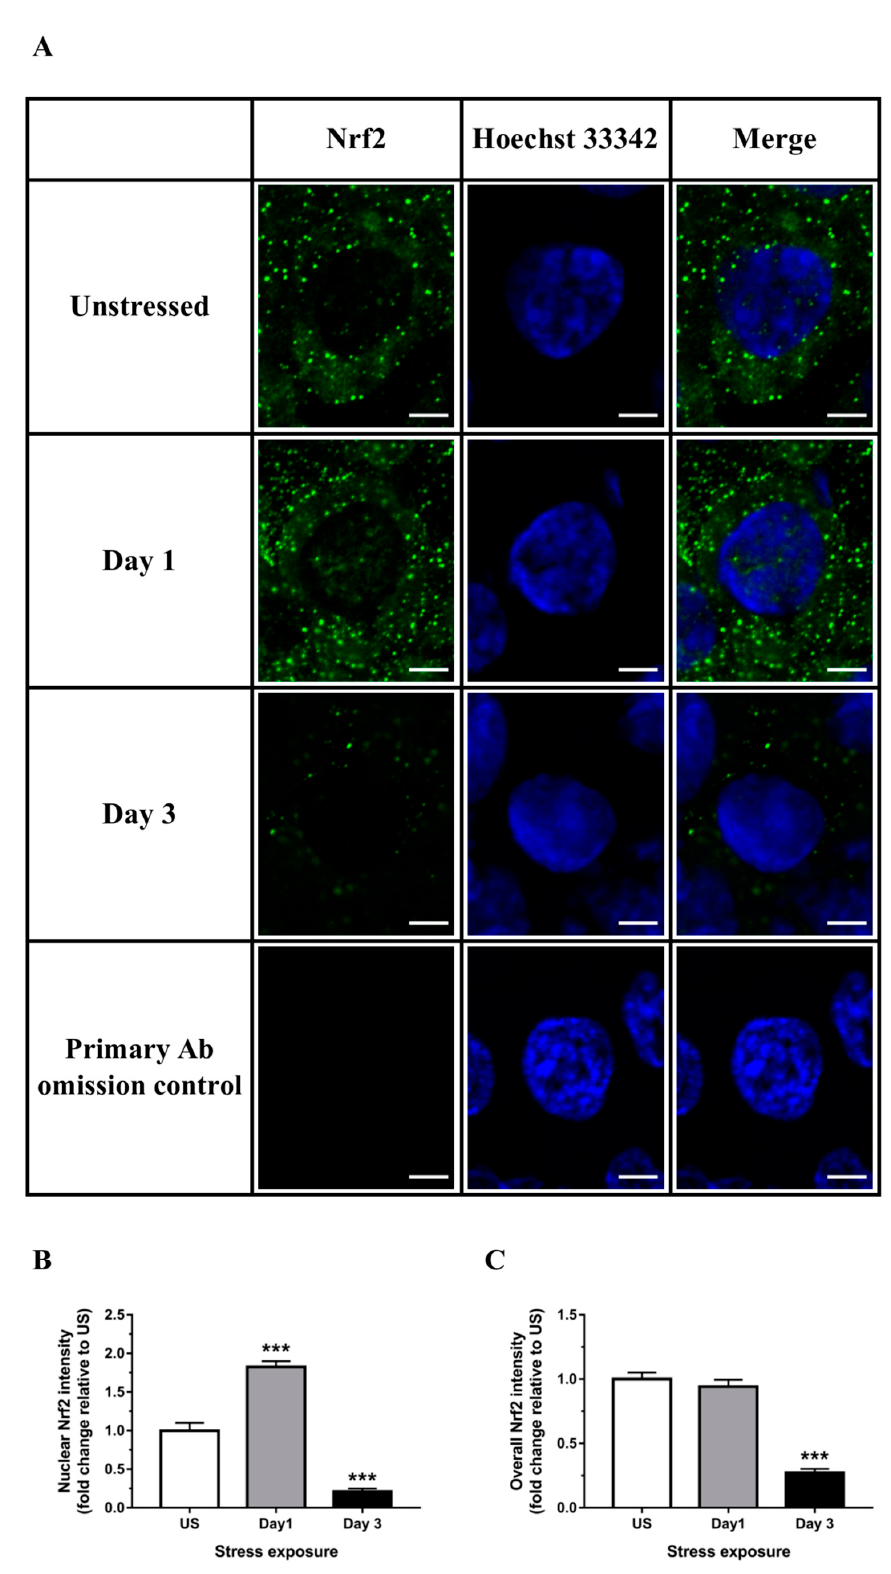
Figure 7. Representative ( A ) immunofluorescence images (scale bar = 5 µm) and image quantification of ( B ) corresponding nuclear Nrf2, and ( C ) overall Nrf2 from tissue sections in the liver (n = 3). Results in ( B ) were analyzed using one-way ANOVA with Fisher’s LSD test. Data are expressed as mean ± SEM, *** p < 0.001.